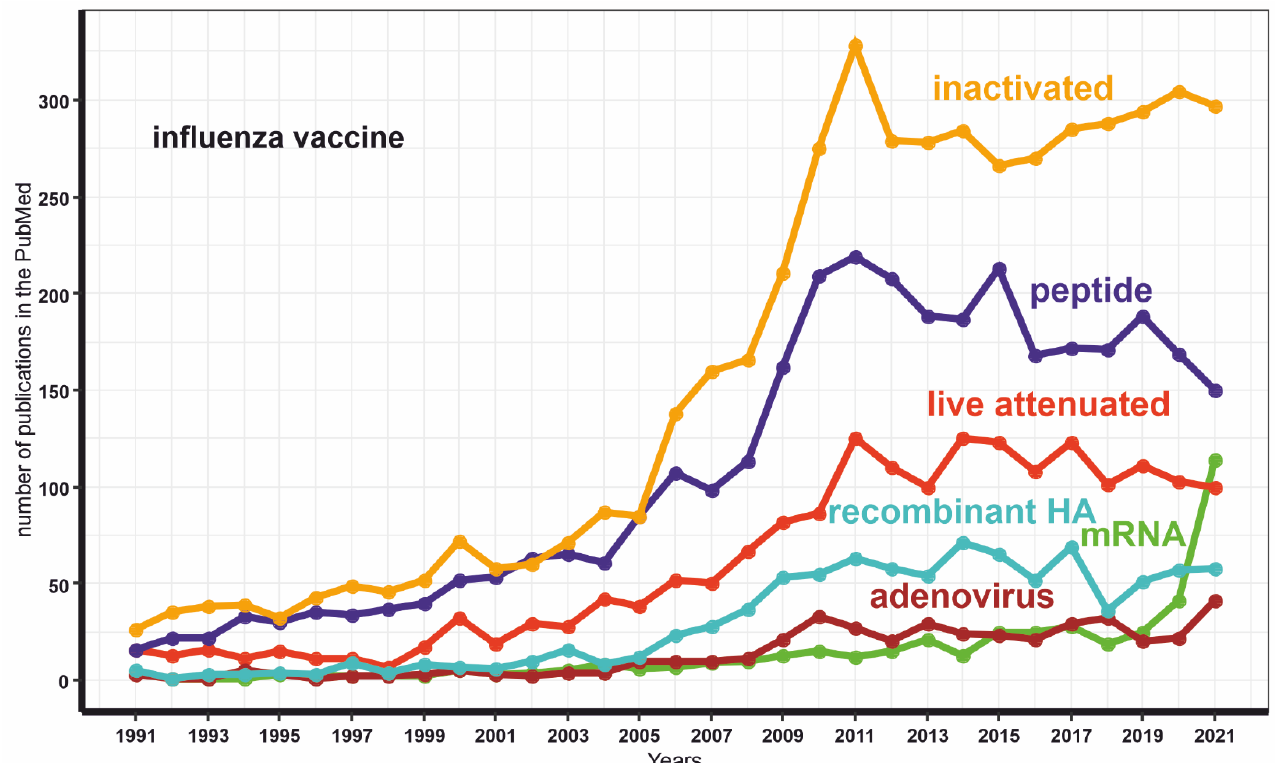
Figure 3. The dynamics of the publications number with keywords “mRNA INFLUENZA VACCINE” or “live attenuated INFLUENZA VACCINE” or “inactivated INFLUENZA VACCINE” or “adenovirus INFLUENZA VACCINE” or “peptide INFLUENZA VACCINE” or “recombinant HA INFLUENZA VACCINE”.